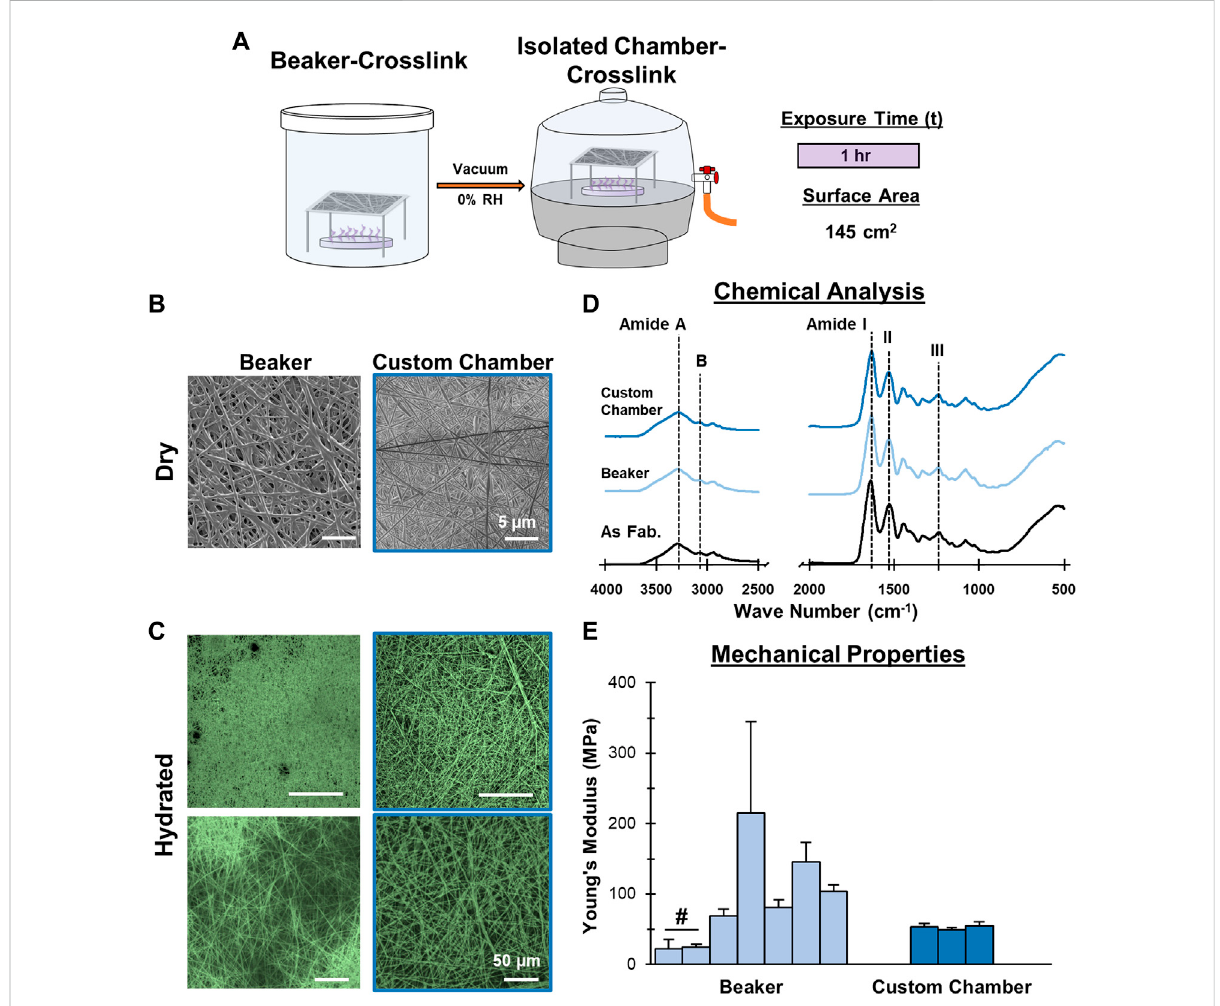
FIGURE 4 Mesh Fabrication: Crosslinking Environmental Conditions . Crosslinking inside a vacuum sealed chamber minimizes batch-to-batch variability. (A) Schematic of the crosslinking procedure. (B) Dry morphology (SEM, 2,500x) and (C) hydrated morphology (CRM, 100x, 300x) of meshesaftercrosslinking. (D) Chemicalcomposition(FTIR-ATR). (E) Young ’ sModuliaftercrosslinkingbybeaker(7batches)andthecustomchamber (3 batches) ( n = 10). #= p <